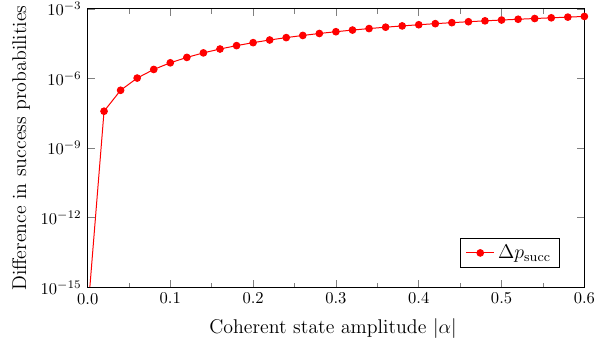
FIG. 8. Difference between the numerically optimized success probability of discriminating QPSK constellations, with the cor- responding approximate solution in Eq. (A7). We note that in the weak signal regime, our analytic solution is a good approximate to the optimized